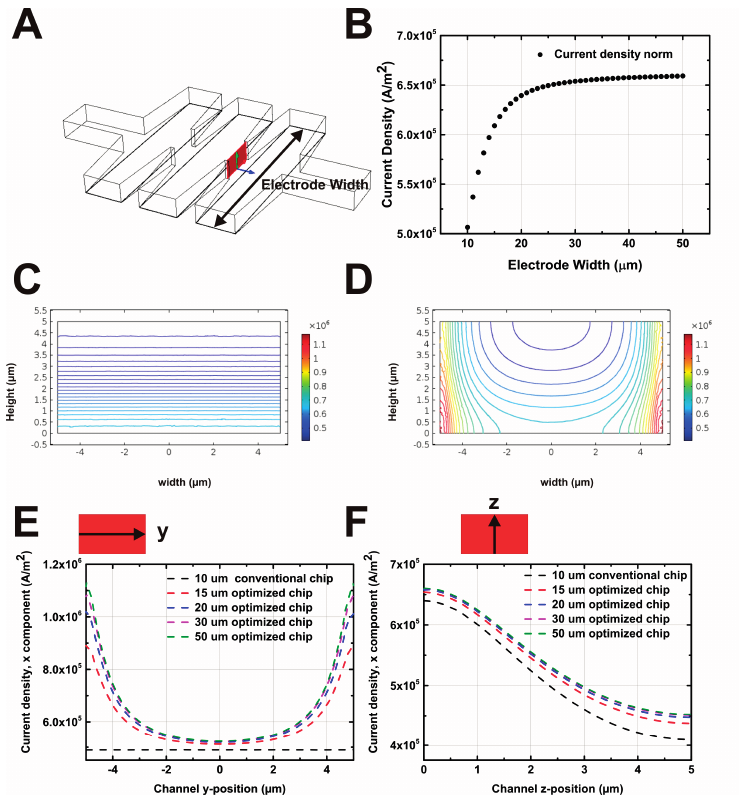
Figure 3. FEM simulation of the current density. ( A ) 3D sketch of the channel with wide electrodes. The current density was evaluated through the detection cross-section (red surface) between the electrodes using FEM. ( B ) Normalized current density through the detection cross-section as a function of electrode length the optimized chip. ( C ) Contour plot of the current density in the detection cross-section for the conventional electrode layout. ( D ) Contour plot of the current density in the detection cross-section for the improved electrode layout. ( E ) Line plot of the x -component of the current density for z = 2.5 μ m as a function of the y -coordinate across the detection cross section for varying electrode widths. ( F ) Line plot of the x -component of the current density for y = 0 μ m as a function of the z -coordinate across the detection cross-section for varying electrode